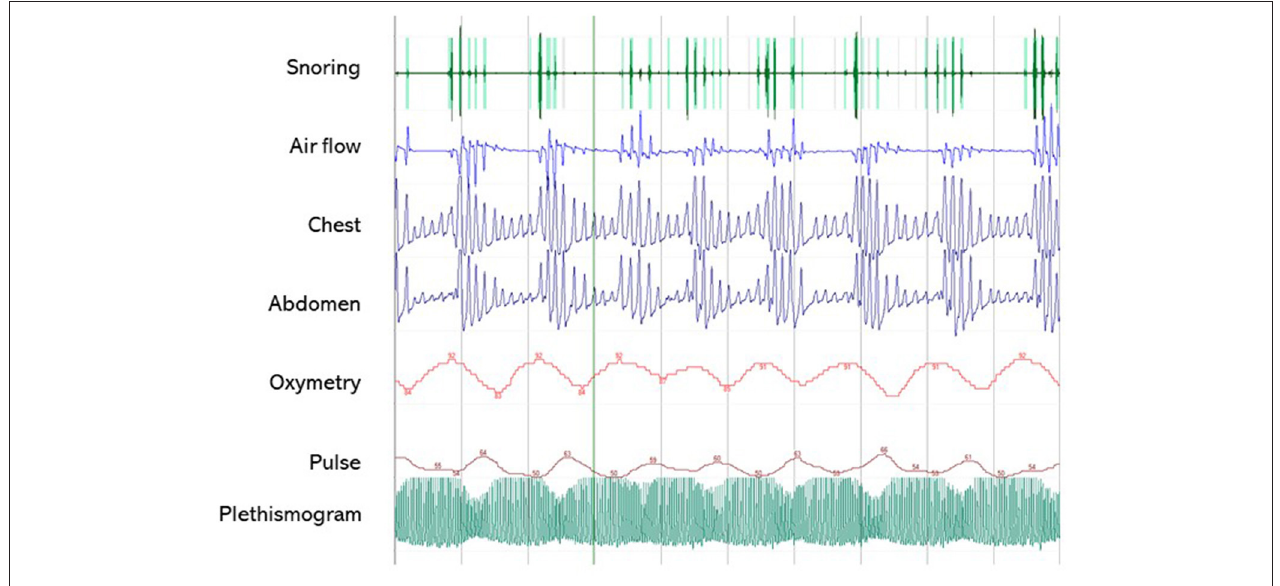
FIGURE 3 | A 5-min segment from home sleep apnea test (HSAT) in the diagnosis of sleep-related breath disorders in a 51-year old male patient with CP. The patient was operated on for a huge supra- and retrosellar craniopharyngioma with hydrocephalus and ataxia, achieving complete resection of an adamantinomatous lesion. He developed post-operative diabetes insipidus and partial hypopituitarism, and had severe weight gain ( + 50kg) with snoring and markedly excessive daytime somnolence (EDS), confirmed by a high ESS score (16/24). HSAT confirmed the presence of severe OSA syndrome (AHI 58.8/h), characterized by several obstructive apneas. PAP treatment induced the disappearance of EDS (ESS score 7/24). Overall, the patient was very compliant to lifestyle interventions and endocrinological management, and significant weight loss ( − 30kg) was also